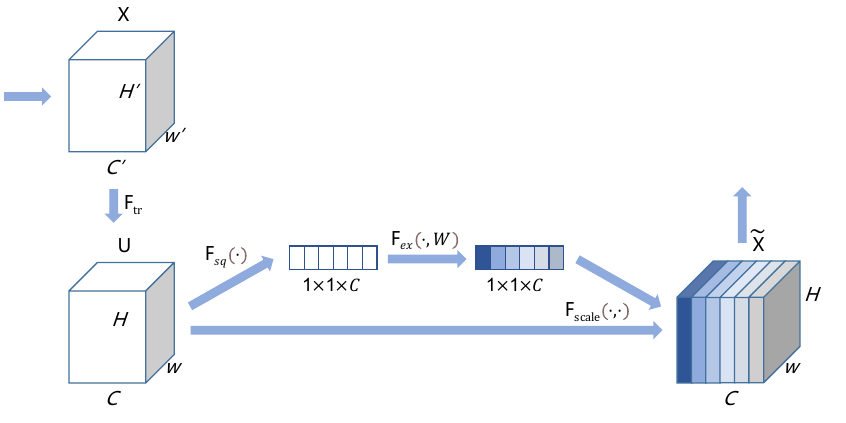
Figure 4. The structure of the SE